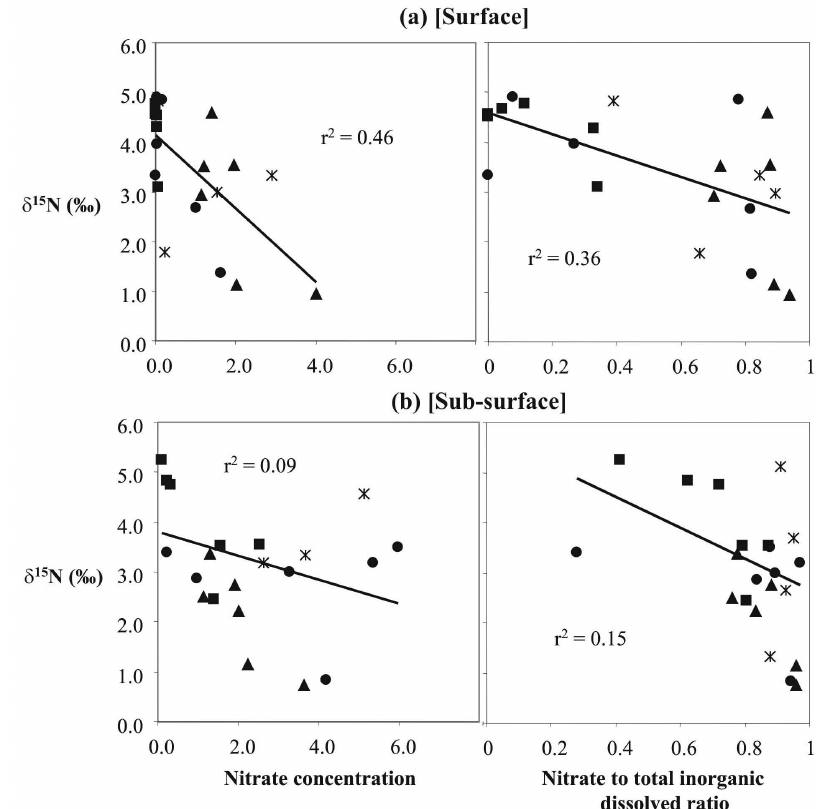
Fig . 5. – Relationship between nitrate concentration (NO 3- , µM) and d 15 N of PON ( d 15 N-PON) and ratio of nitrate to dissolved inorganic nitrogen (NO 3- :DIN) and d 15 N of PON for surface (a) and sub-surface chl a fluorescence maximum (b) samples in summer (circles), autumn (squares), winter (triangles) and spring